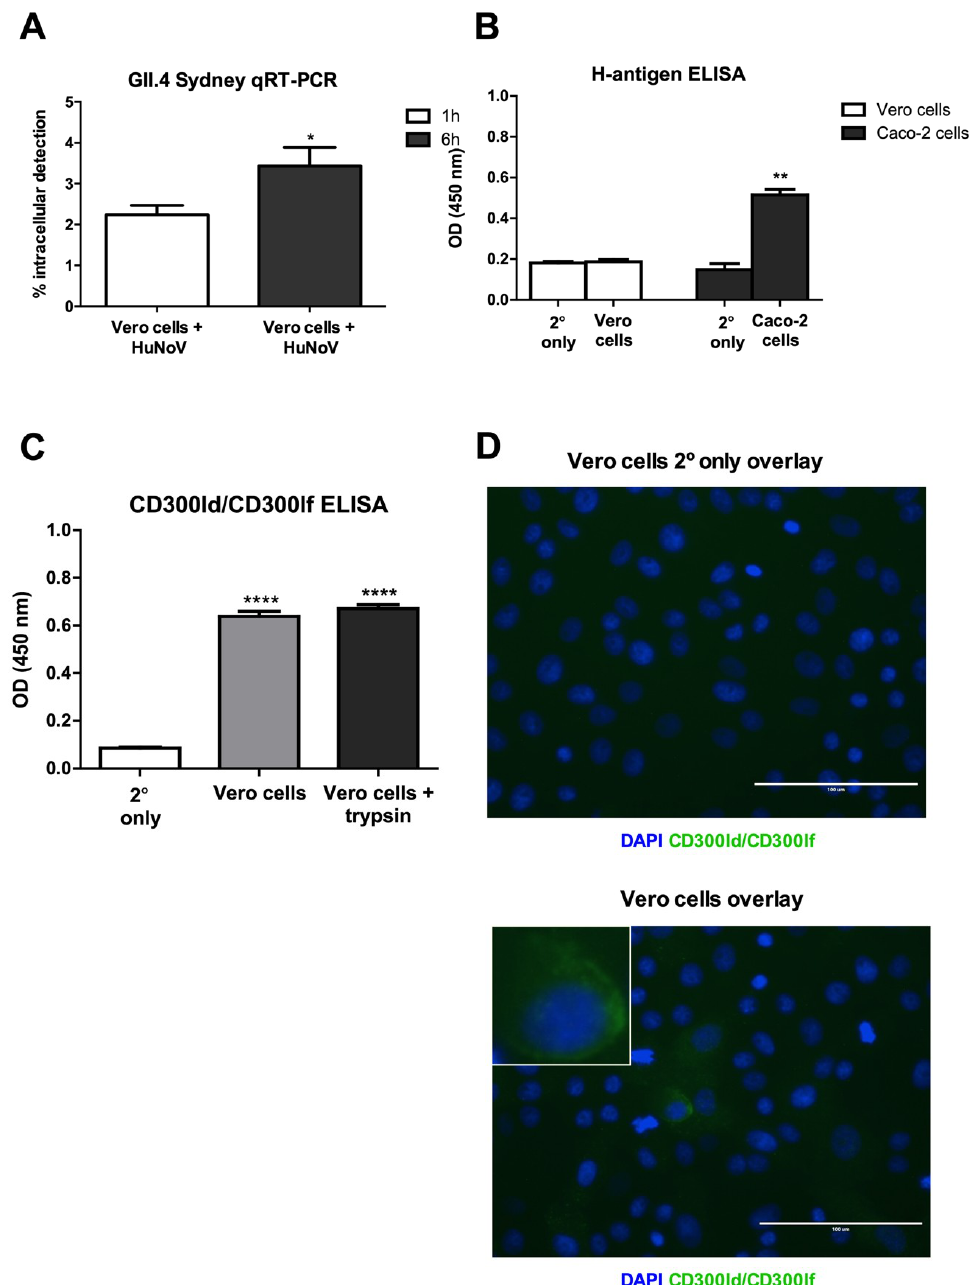
Figure 1. ( A ) GII.4 HuNoV detection by qRT-PCR. qRT-PCR analysis of RNA extracted from HuNoV- infected Vero cells. Data represent n = 3 + SEM. * p < 0.05. ( B ) Vero cells do not express detectable H-antigen. An indirect ELISA was used to detect the H-antigen on the cell surface of Vero cells and Caco-2 cells. No signal was observed for secondary only antibody controls (2 ◦ ). Data represent n = 4 (Vero cells H-antigen ELISA) or n = 1 (Caco-2 cell H-antigen ELISA) + SEM. ** p < 0.01. ( C ) Vero cells express CD300ld / CD300lf. Anti-CD300lf (ectodomain) indirect ELISA of Vero cells following 24-h treatment ± 8.8 BAEE of trypsin. No signal was observed for secondary only antibody controls (2 ◦ ). Data represent n = 3 + SEM. **** p < 0.0001. ( D ) CD300ld / CD300lf expression on Vero cells by immunofluorescence. A representative image is shown at 40 × magnification from n = 3 biological replicates. CD300ld / CD300lf-associated fluorescence was not observed for secondary antibody only (2 ◦ ) treated cells. The inset shows a CD300ld / CD300lf-expressing Vero